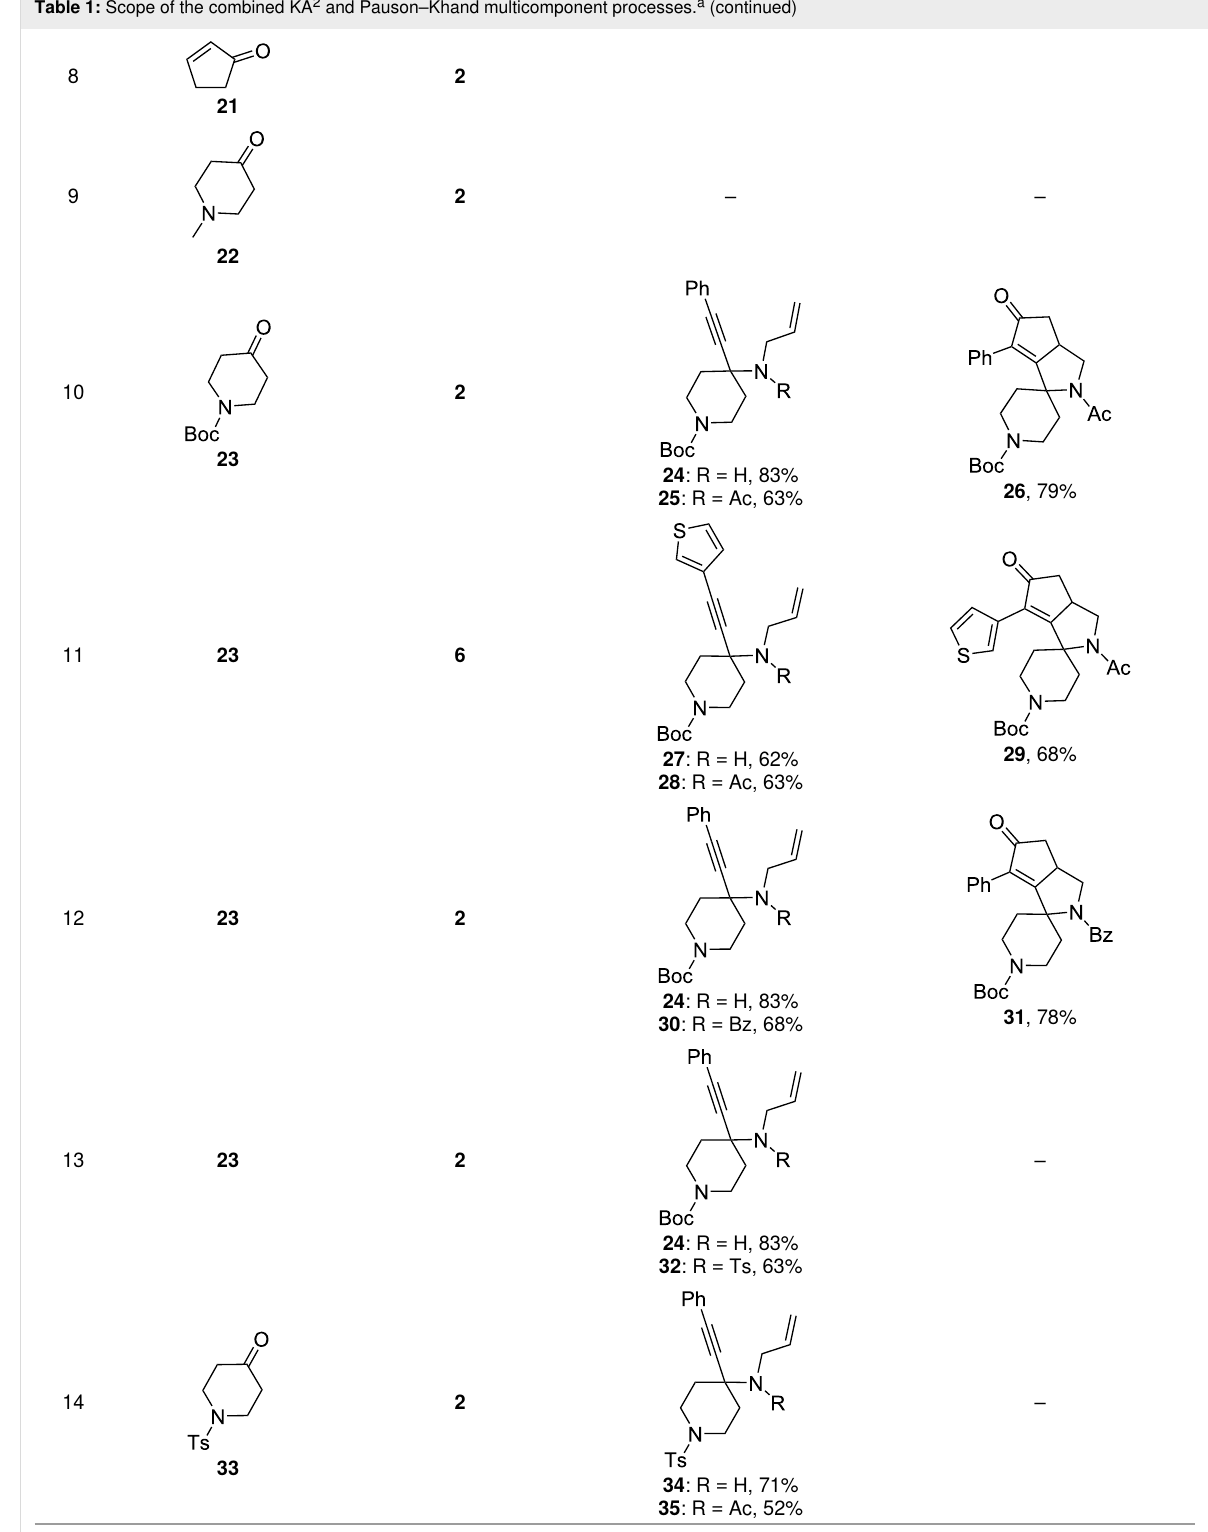
Table 1: Scope of the combined KA 2 and Pauson–Khand multicomponent processes. a (continued)